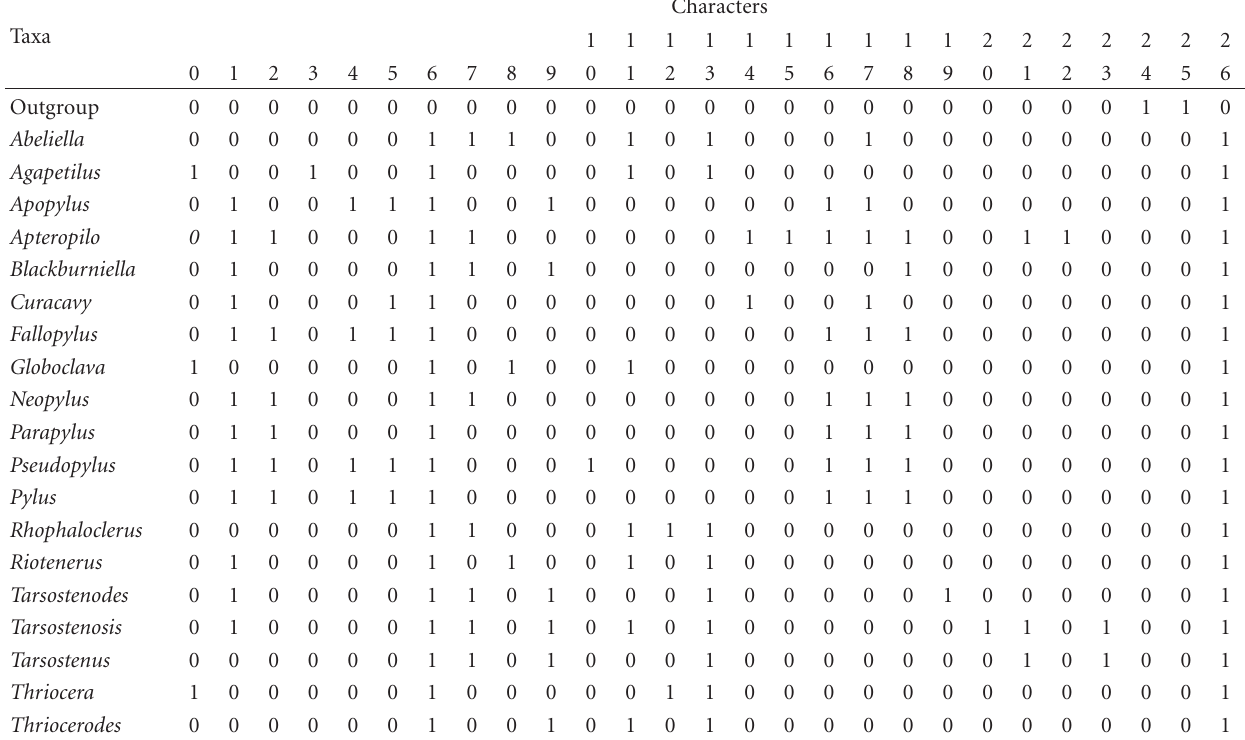
Table 1: Character matrix for 27 morphological characters of Tarsosteninae